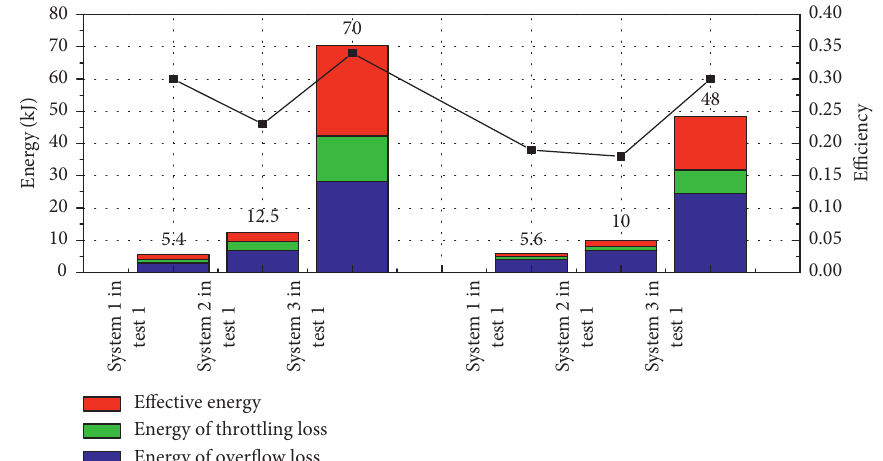
Figure 23: Energy distribution and contrast of the three